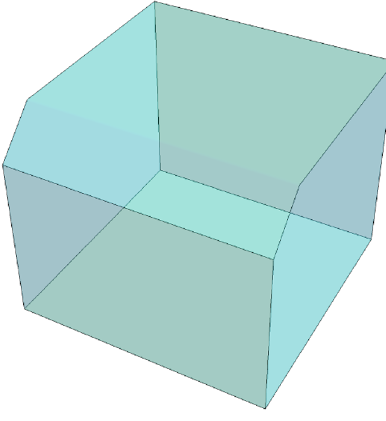
Figure 18 . Accordiohedron from dissection (14 , 510 , 710)